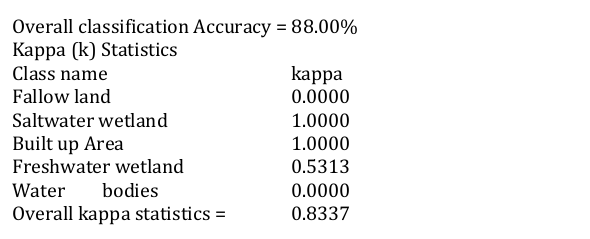
Table 6: Accuracy total report (2003) of Port Harcourt